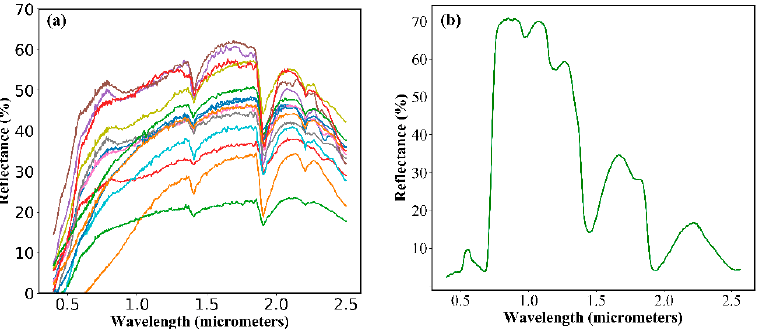
Figure 2. ( a ) Spectral response curves of 14 kinds of soil, provided by the ASTER Spectral Library [22]; ( b ) spectral response curve of green vegetation. ( b ) spectral response curve of green